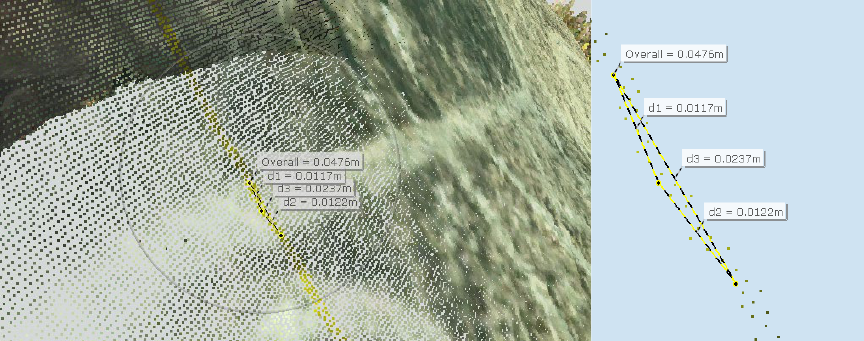
Figure 10. Visualisation of the carving depth determination method.